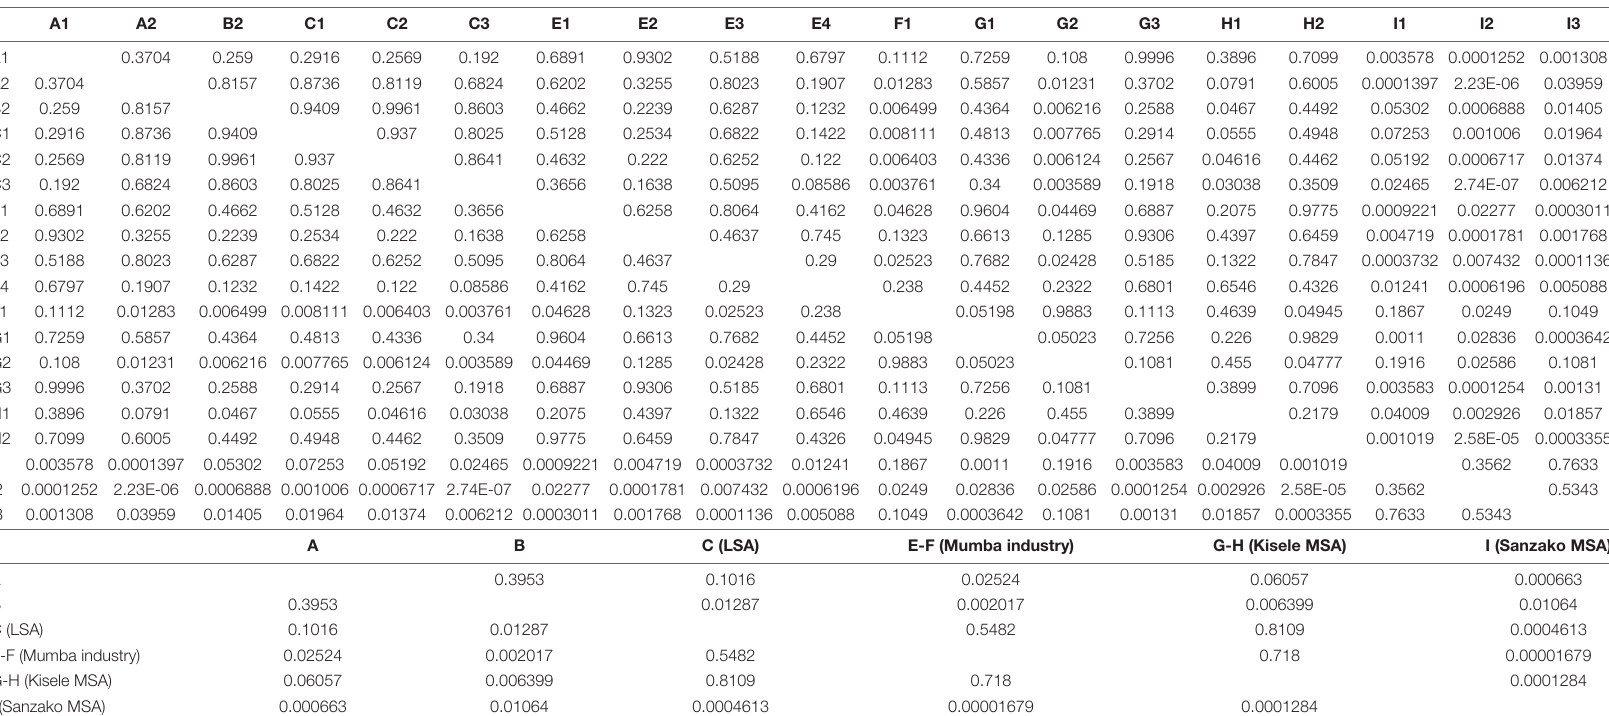
TABLE 6 | Raw p -values from Dunn’s post hoc test on phytolith distribution (significant values are shaded) and per chronological and cultural